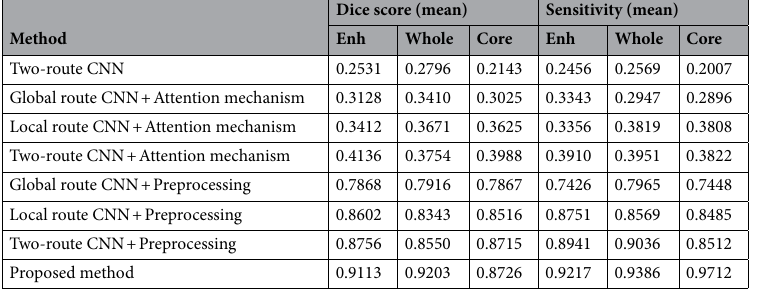
Table 1. Evaluation results with different pipeline configurations on BRATS 2018